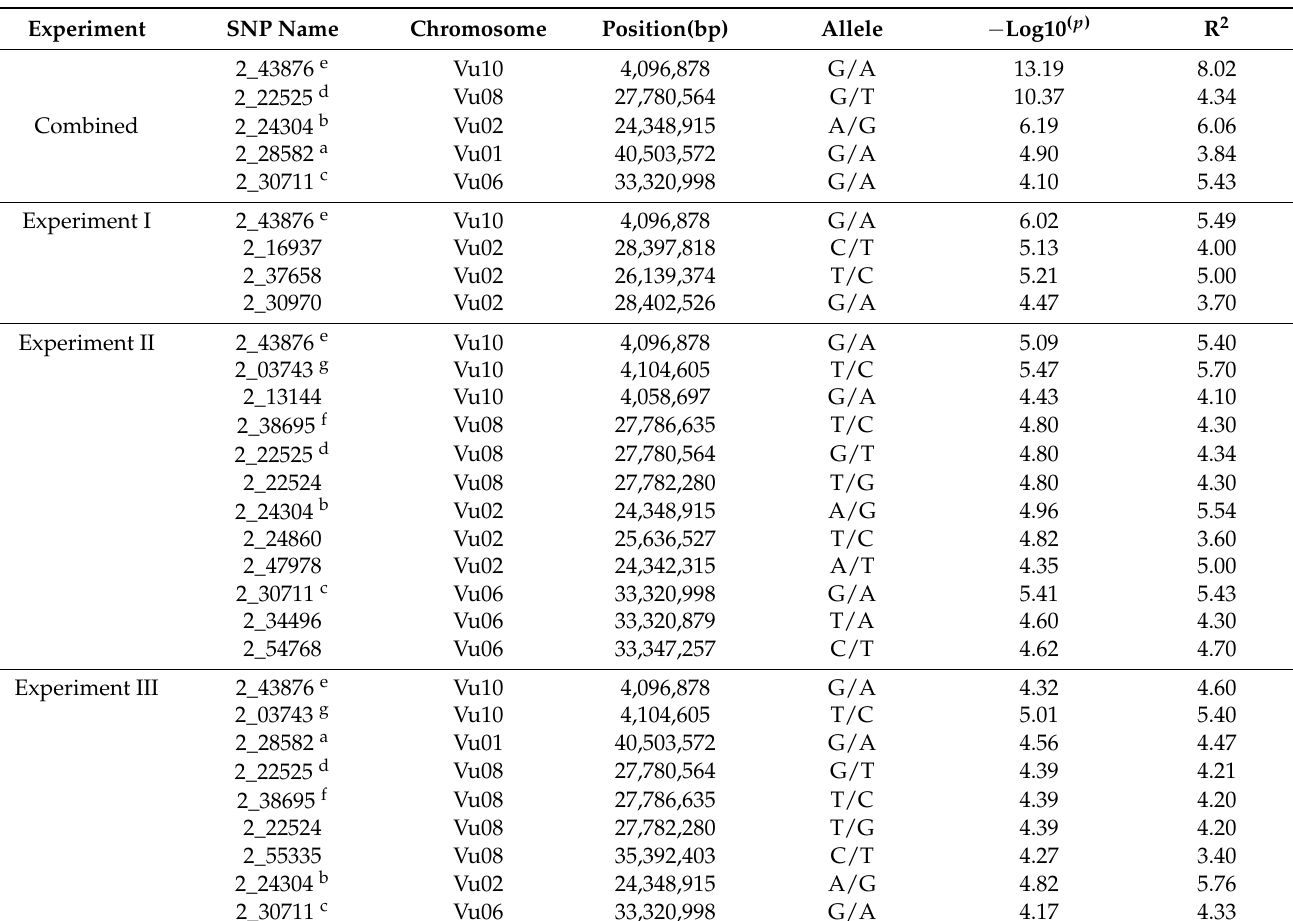
Table 3. Representative significant SNPs that were associated with resistance to A. craccivora rated based on aphid damage severity in the cowpea mini-core